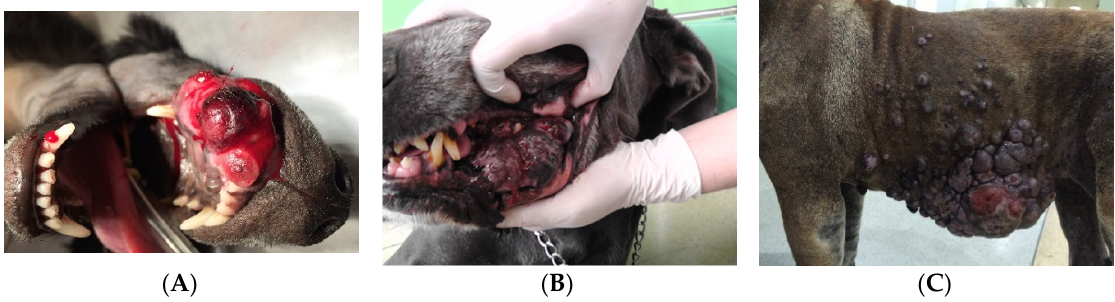
Figure 1. Clinical aspect of malignant oral melanomas ( A ) in maxilla; ( B ) in mandible. Clinical aspect of malignant cutaneous melanoma ( C ) in thoracic and abdominal wall ( Adriana Nihiya ).